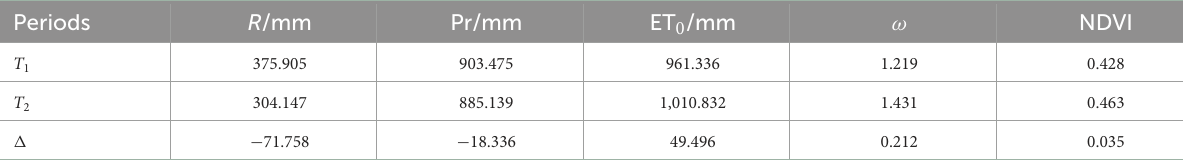
TABLE 1 The eigenvalues of climate, hydrology, and Normalized Difference Vegetation Index (NDVI) variables in the Lancang River Basin (LCRB). Periods